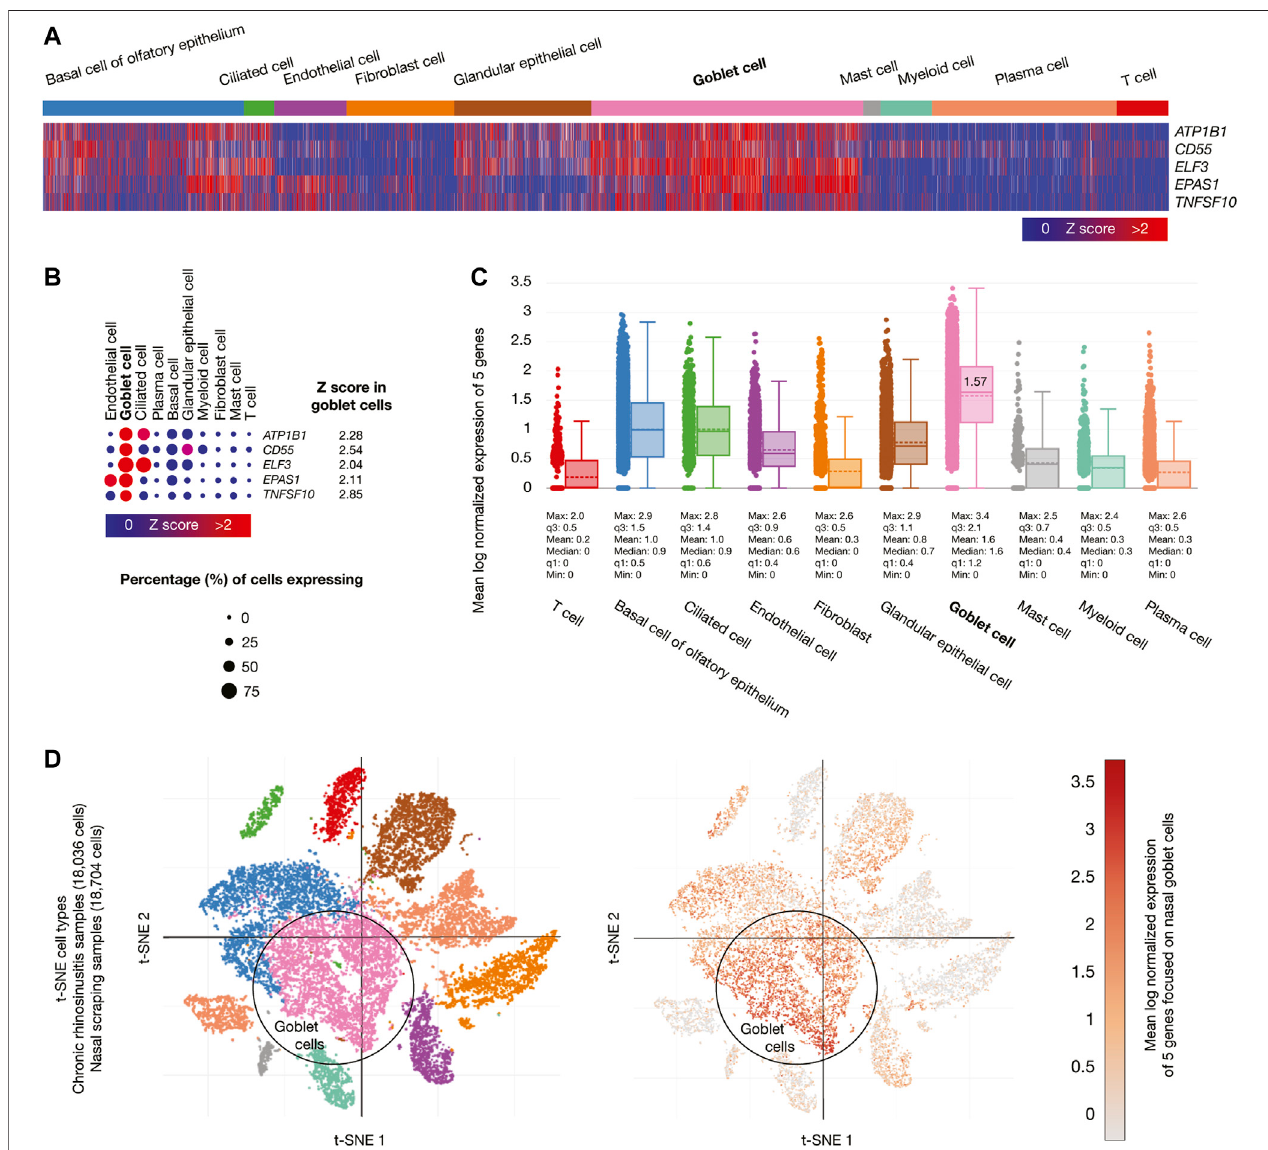
FIGURE 4 | Single-cell RNA-sequencing data analysis of the high-con fi dence immune system nodes in nasal passage cells. (A) Heatmap of signi fi cant overexpressed genes (Z-score > 2) in nasal goblet secretory cells. (B) Dot plot of signi fi cant overexpressed genes in nasal goblet secretory cells and percentage of cells expressing. (C) Box plots of nasal passage cell types according to their mean log normalized expression. (D) t-distributed stochastic neighbor embedding cell type and mean log normalized expression focused on nasal goblet secretory cells.